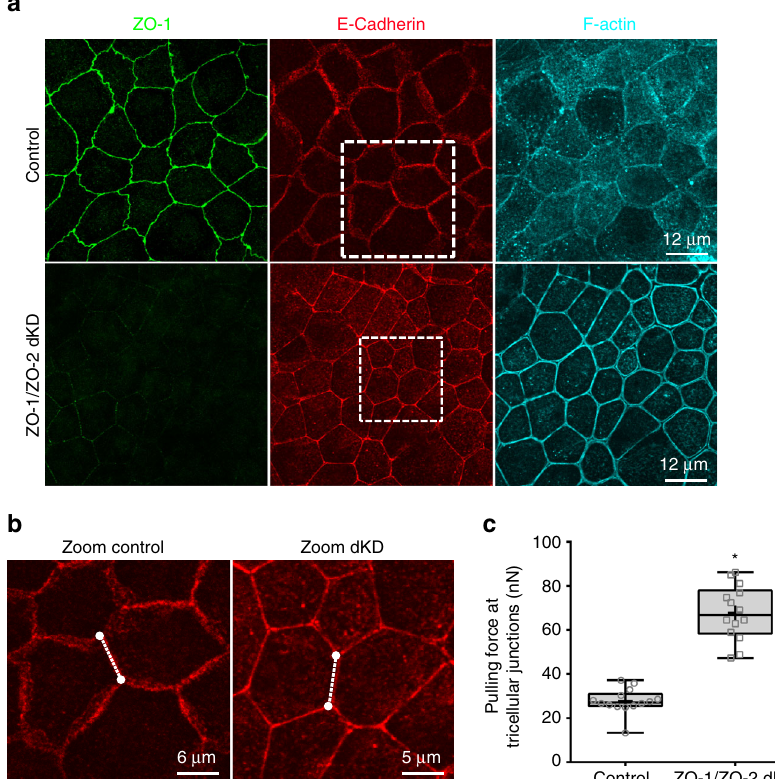
Fig. 6 Pulling forces at tricellular junctions increases with depletion of ZO-1 and ZO-2. a Representative confocal images of polarized monolayers of MDCK II Tet-Off controls and ZO-1/ZO-2 dKD cells were grown on glass dishes, fi xed, and stained with Alexa Fluor 647-phalloidin (F-actin) and antibodies against tight junction protein ZO-1, the adheren junction protein E-cadherin. The cell shapes of dKD cells are different (more polygonal) than controls, and the adherens cell – cell contacts are straighter. Boxed areas are shown zoomed in ( b ). ( b ) Zoomed areas of E-cadherin images depict pair of cells with hexagonal shapes within the polarized epithelium. Dashed lines represent the cell – cell junctions utilized for length estimation. All confocal images are 1.05 µ m thick maximum intensity Z-projections. c The plot show that for ZO-1/ZO-2 dKD monolayers the pulling forces acting at tricellular junctions signi fi cantly increases compared to controls ( F control = 27.8 ± 5.7 nN vs. F dKD = 67.8 ± 12.4 nN). In c , data are represented as mean ± s.d.; * indicates signi fi cant difference in comparison with control P < 0.05 (unpaired two-tailed Student ’ s t -test with Welch ’ s correction); number of measurements pooled for each condition n =